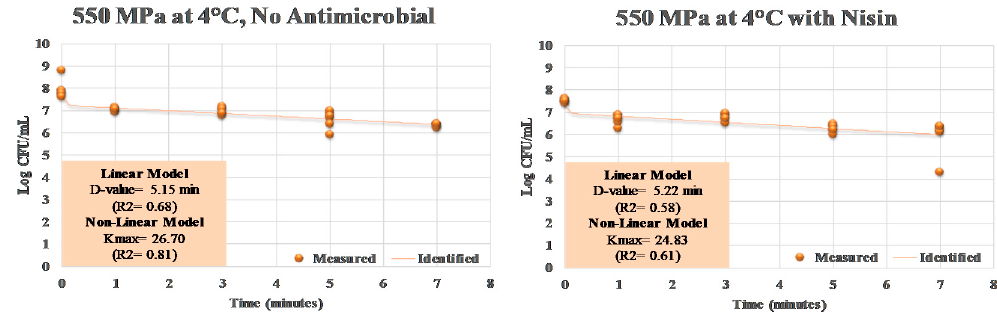
Figure 4. Linear and non-linear inactivation indices for S. aureus exposed to elevated hydrostatic pressure (550 MPa at 4 °C) in the presence of 5000 IU of nisin. Measured = Actual observations; Identified = Best-fitted non-linear model.